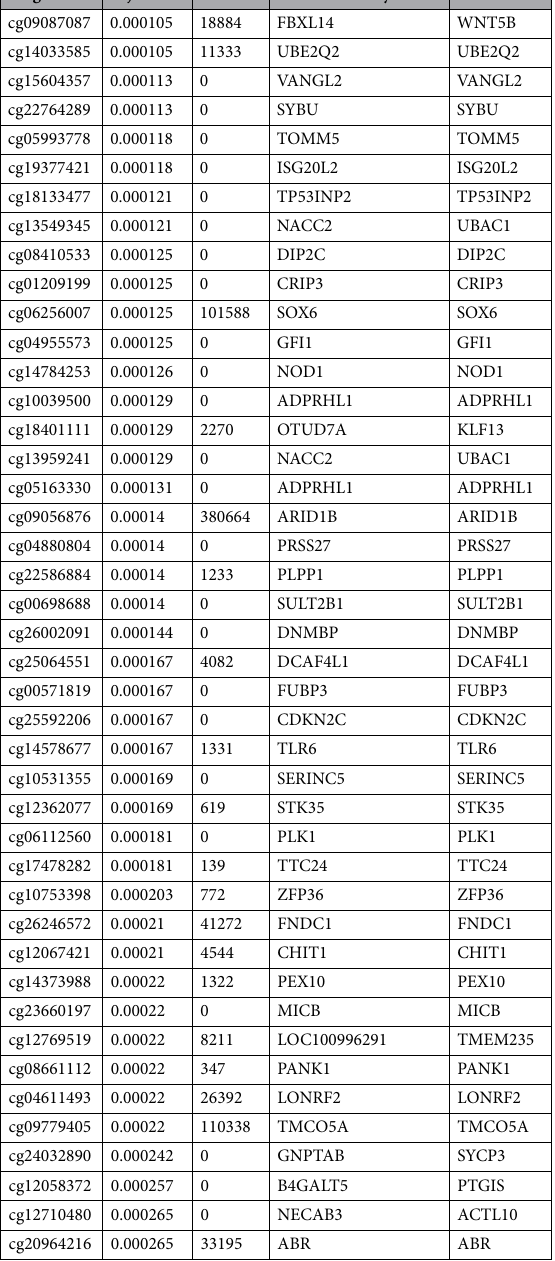
Table 1. Differentially methylated positions (DMPs). Top 100 most significant DMPs are shown (FDR < 0.05, delta-beta >